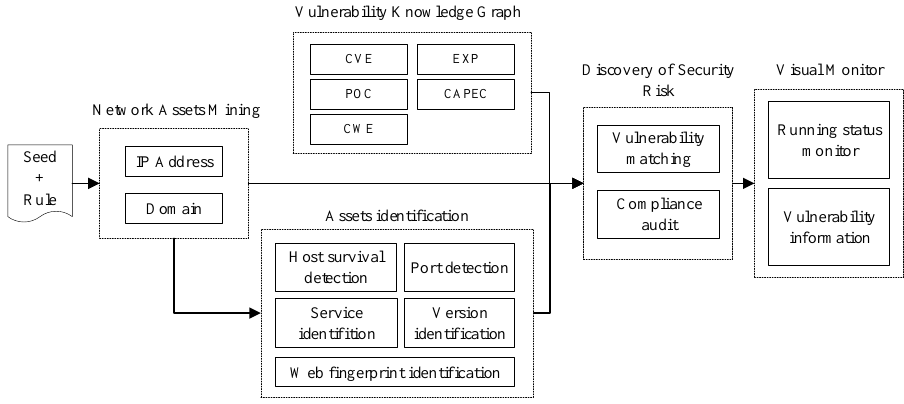
Figure 2. System framework diagram.